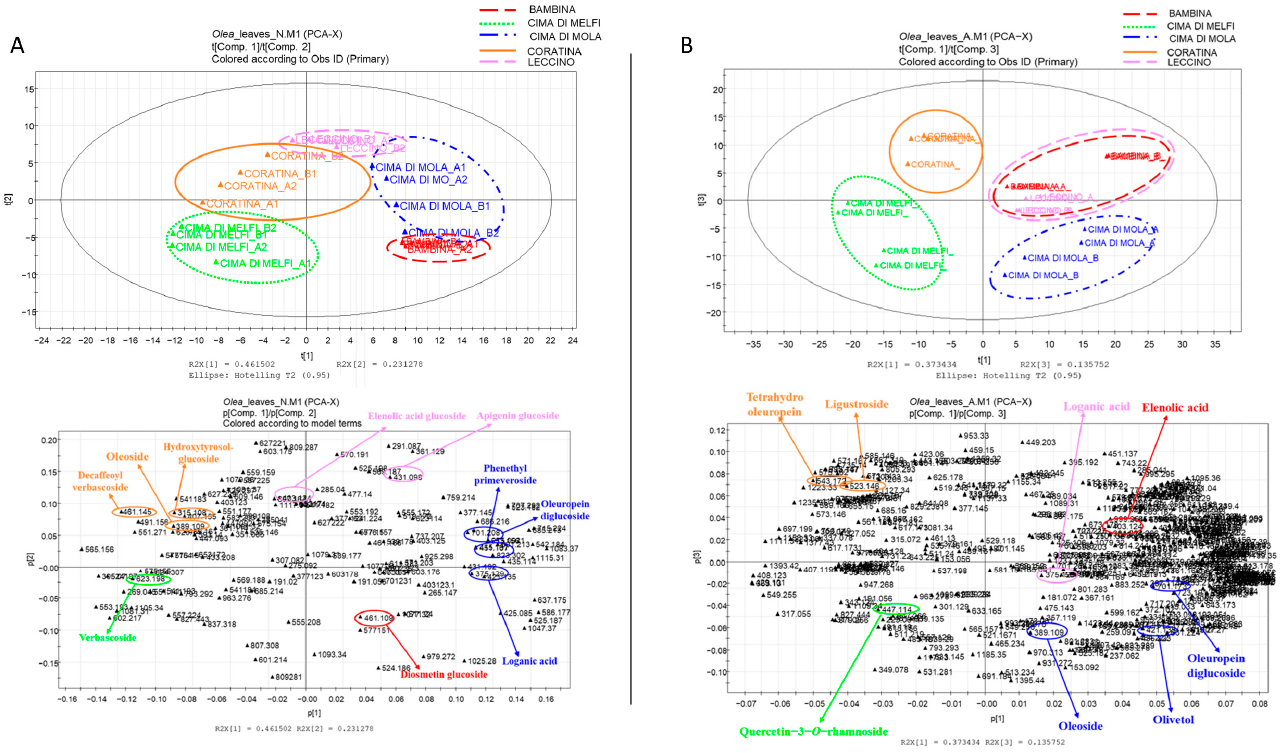
Figure 2. Principal component analysis (PCA) of hydro-alcoholic extracts of Olea europea April ( A ) and November ( B ) leaf extracts. Score scatter plot at the top and loading scatter plot at bottom. In loading scatter plot, biomarkers of any cultivar are underlined.